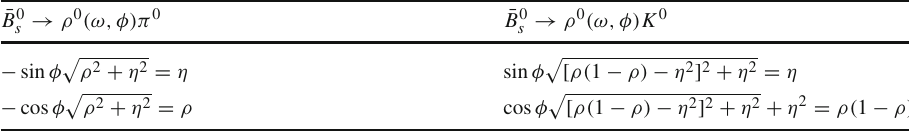
Table 2 The relationships about ρ and η for ¯ B 0 → ρ (ω,φ)π 0 ( K 0 ) decay s